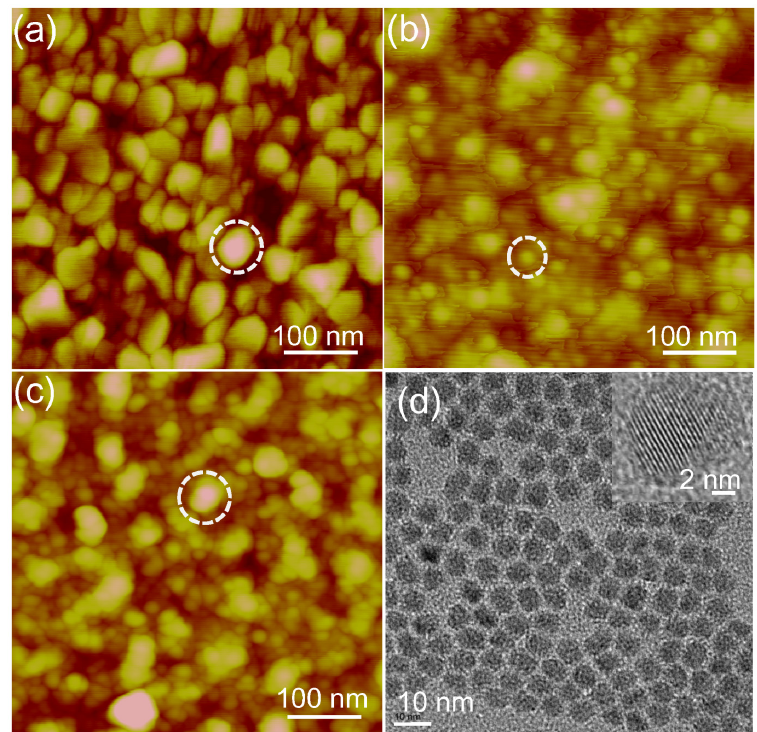
Figure 3. The morphology images obtained from scanning tunneling microscopy for ( a ) bare Au; ( b ) CdSe-ZnS on Au; and ( c ) azurin/CdSe-ZnS/Au. Images were obtained at a scan rate of 1 Hz. The section analysis shows the corresponding height and width of the particles of each obtained image. ( d ) HR-TEM image of CdSe-ZnS nanoparticles inset shows the lattice structure of a single CdSe-ZnS particle.